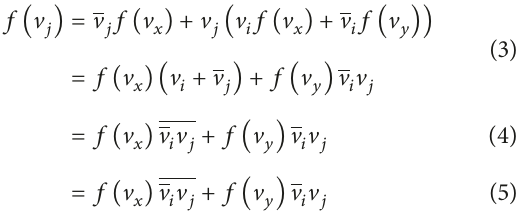
which can be mapped to a DTIG FinFET basic logic gate, such as AND/NAND, OR/NOR, AOI, XOR, and MUX. Here 𝐺 rooted by V 𝐺 𝑖 is a subgraph in 𝑖 with its children and the